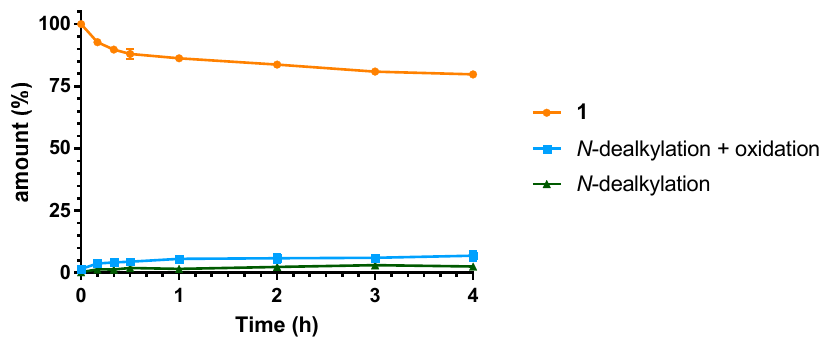
Figure 4. Metabolic stability of 1 and the formation of main metabolites ( N -dealkylation as well as oxidation and N -dealkylation of 1 ).